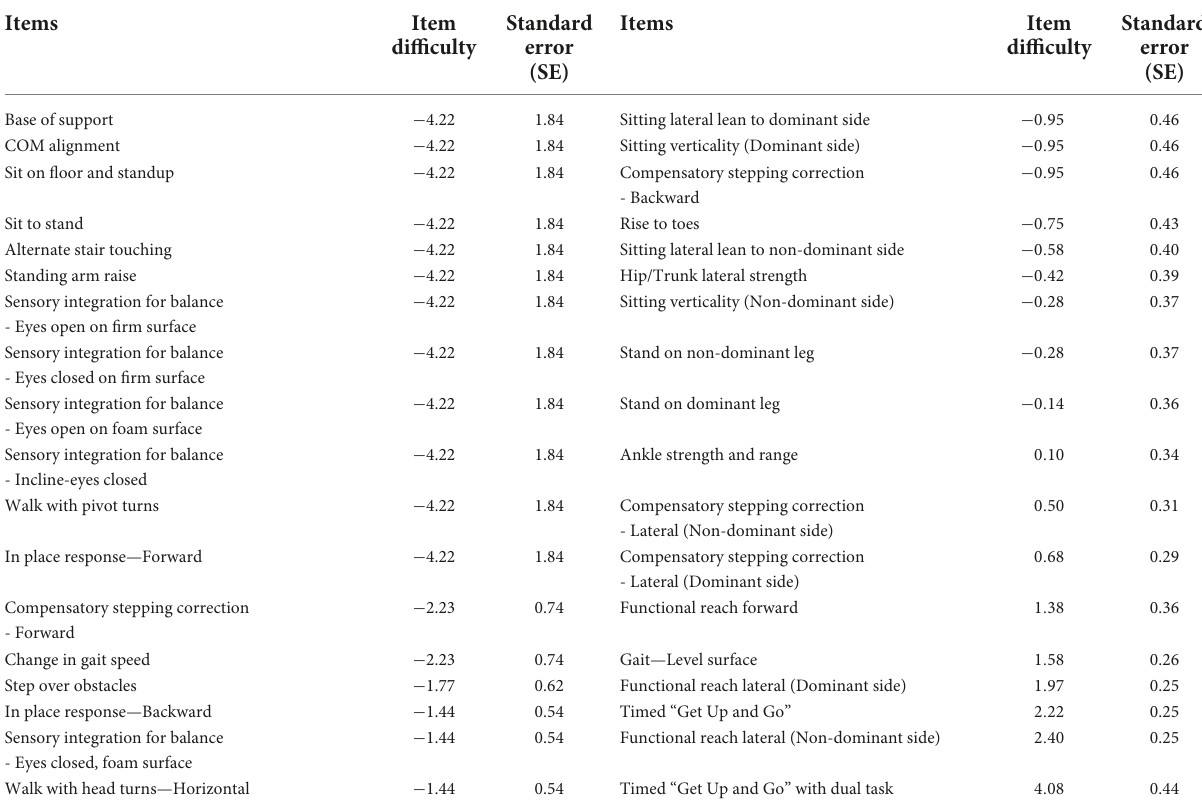
TABLE 6 Item difficulty measures of the BESTest in older adults without chronic neck pain